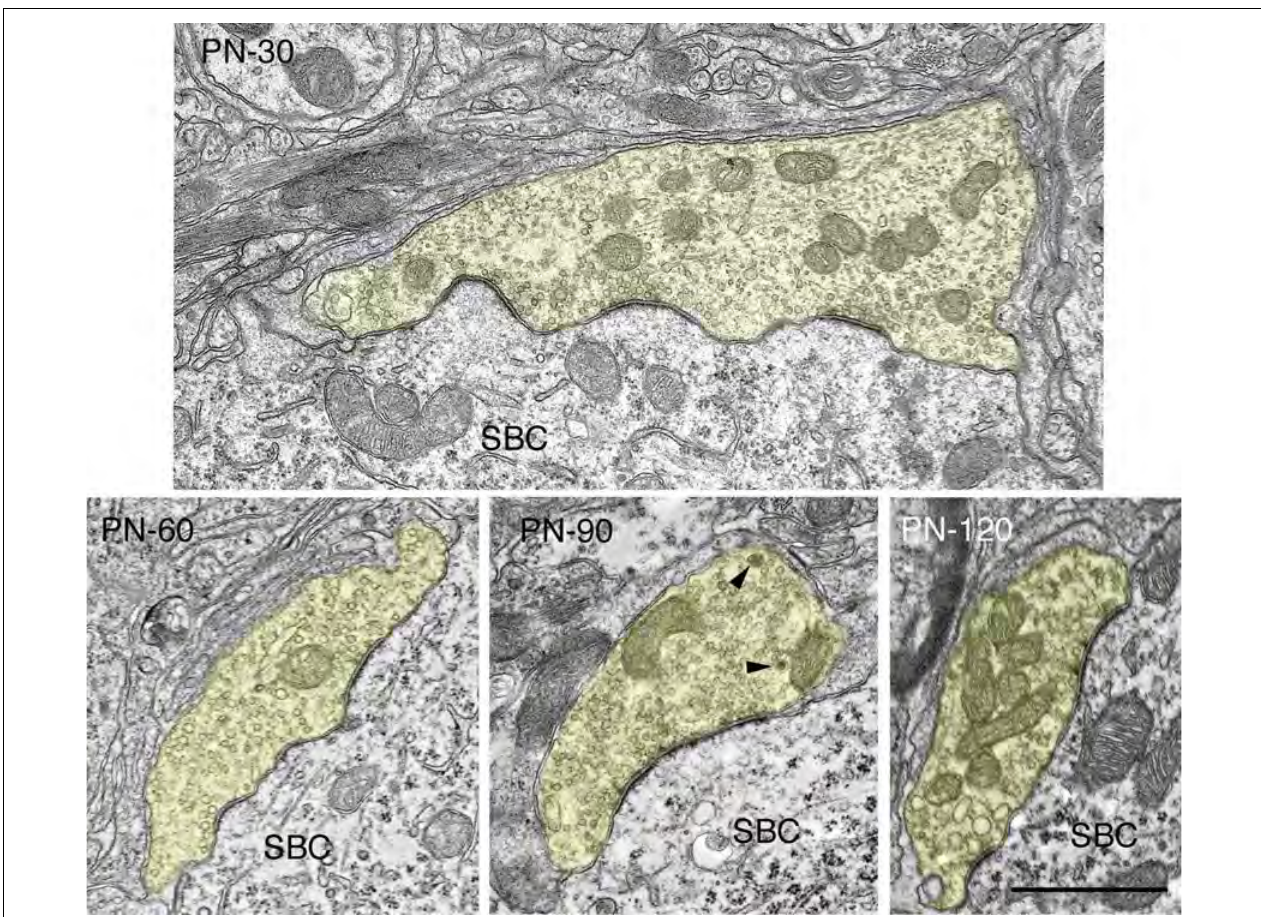
reorganized from a highly corrugated surface to a smooth interface. The number of PSDs has decreased, whereas the lengths of the PSDs have increased. Large dense-core vesicles (arrowheads) are still present though their numbers have decreased. Scale bar equals 1